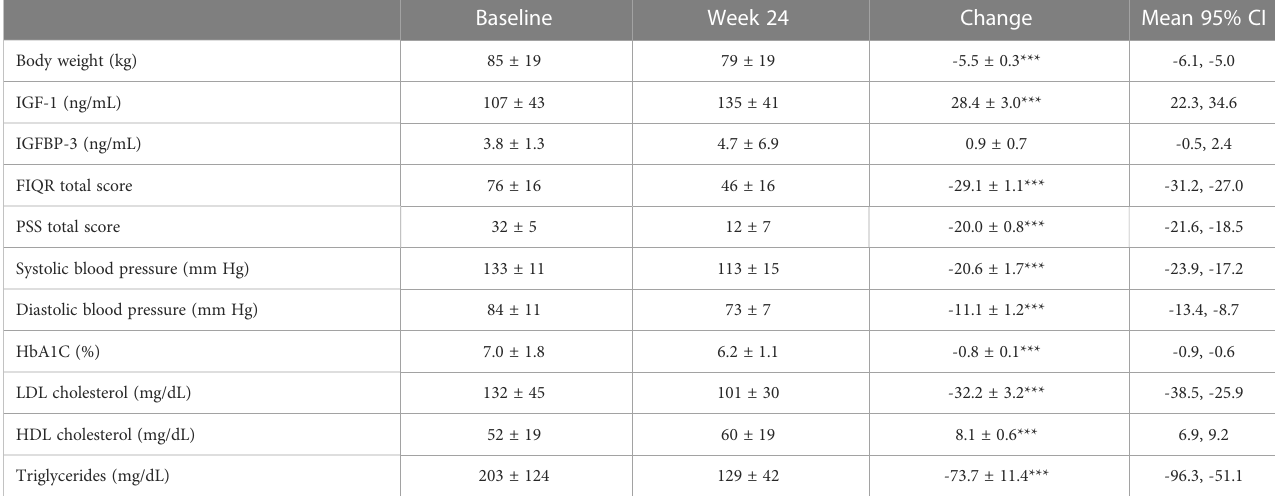
TABLE 1 Baseline and week 24 assessments for all